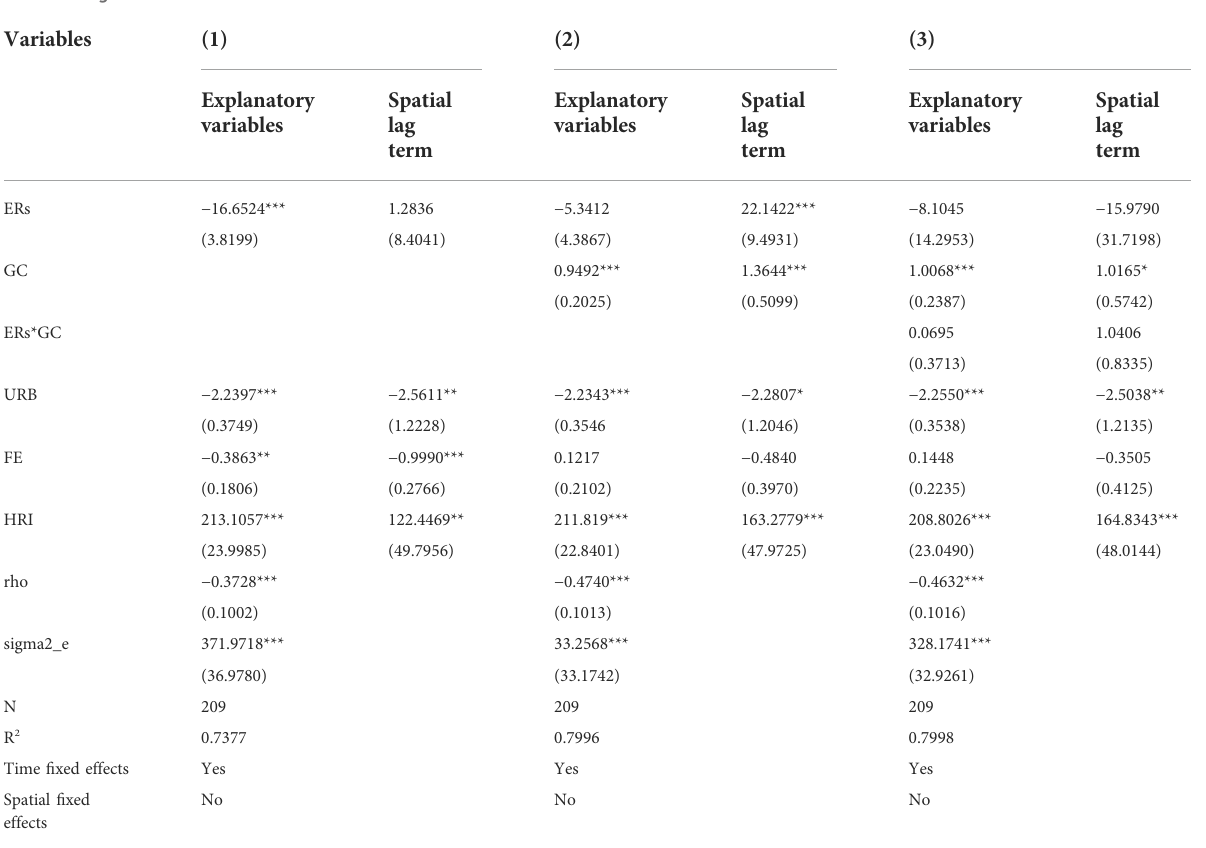
TABLE 5 Regression results for inland